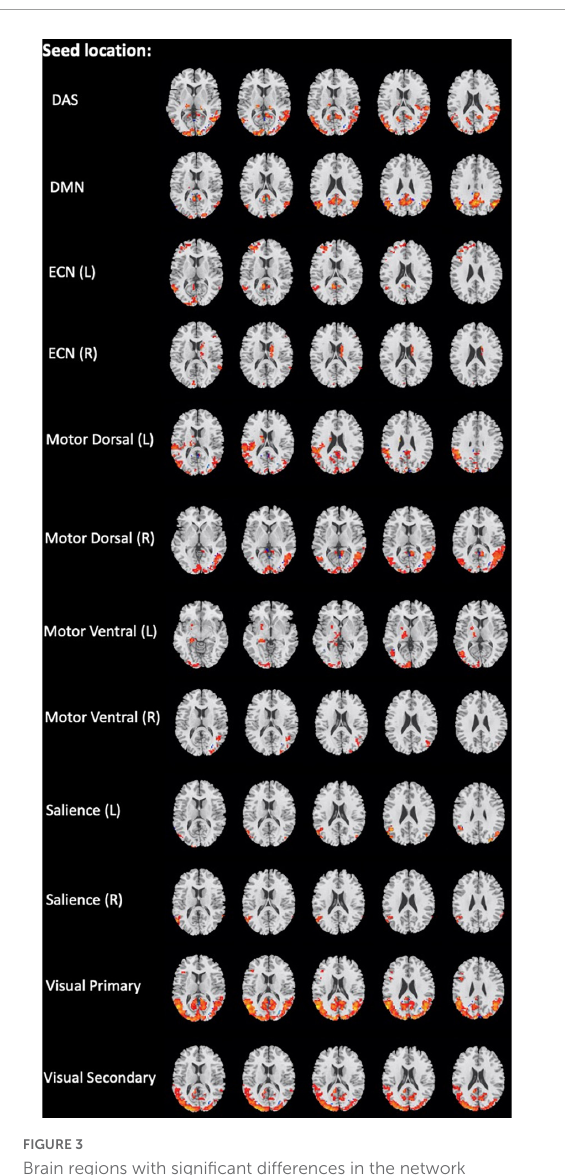
FIGURE3 Brain regions with significant differences in the network seed-based functional connectivity measures between the mild traumatic brain injury (mTBI) and healthy controls (HCs) groups (two-sample t -test, GRF-corrected, voxel-level p < 0.001, cluster-level p < 0.01).